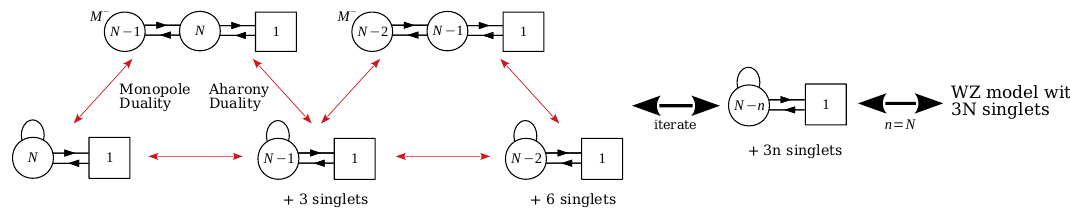
Figure 1 . Diagrammatic representation of the manipulations we perform in the derivation of the